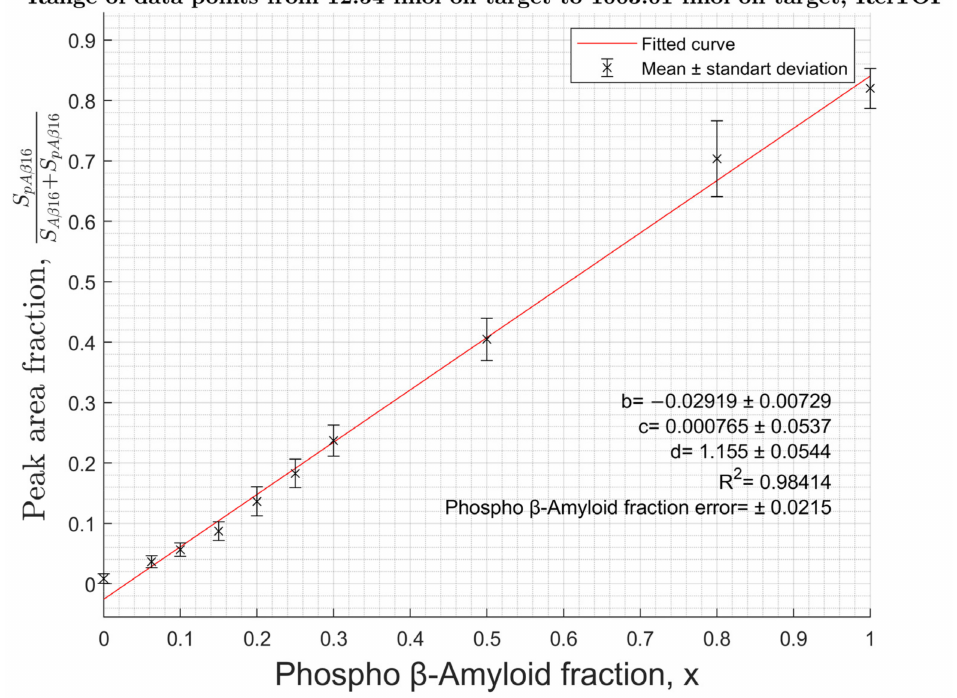
Figure 4. Calibration curve for A β 16 in reflectron mode on an AnchorChip target with 10 mg/mL DHB, 0.1%